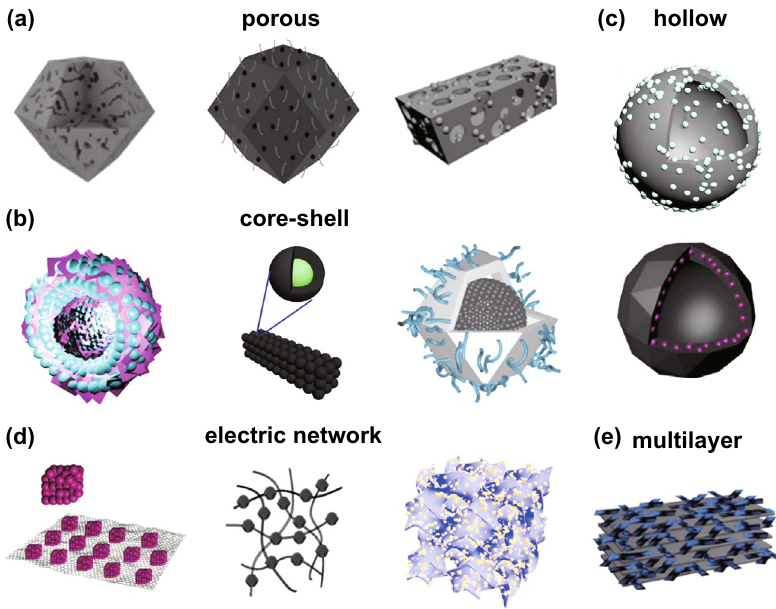
Fig. 1 MOF-derived MAMs with different microstructures: a porous structure, b core–shell structure, c hollow structure, d electric network, and e multilayer structure. Reprinted with permission from Refs.